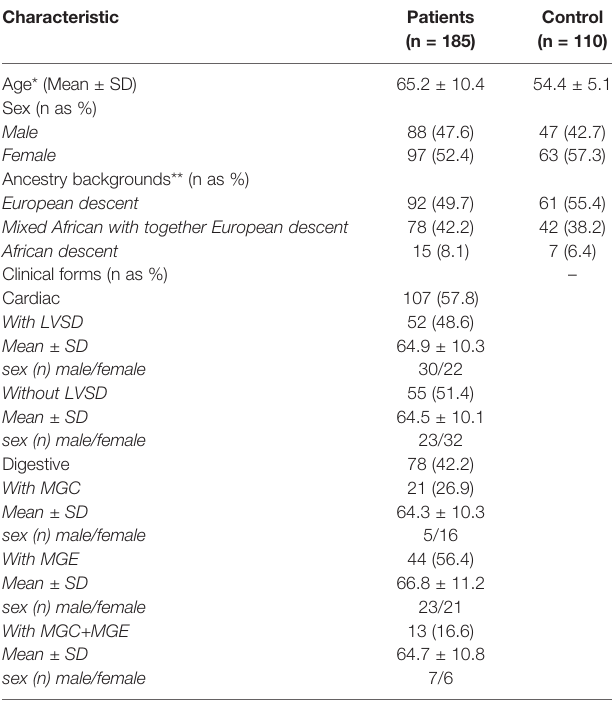
TABLE 1 | Characteristics of the chronic Chagas disease patients and control individuals. Characteristic Patients Control